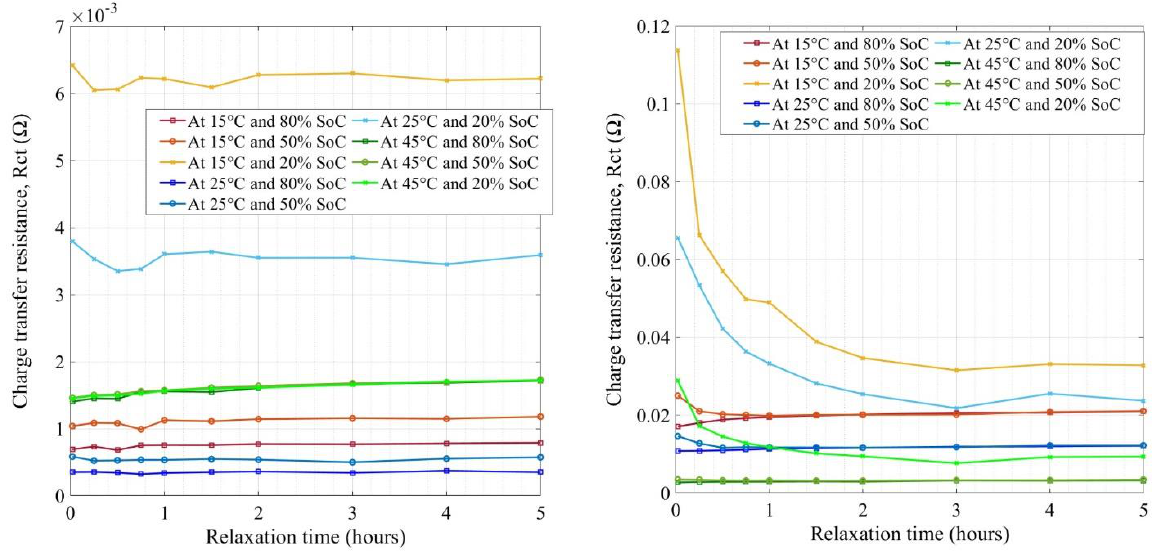
Figure 11. Charge transfer resistance for new ( left ) and aged ( right ) LTO cells.